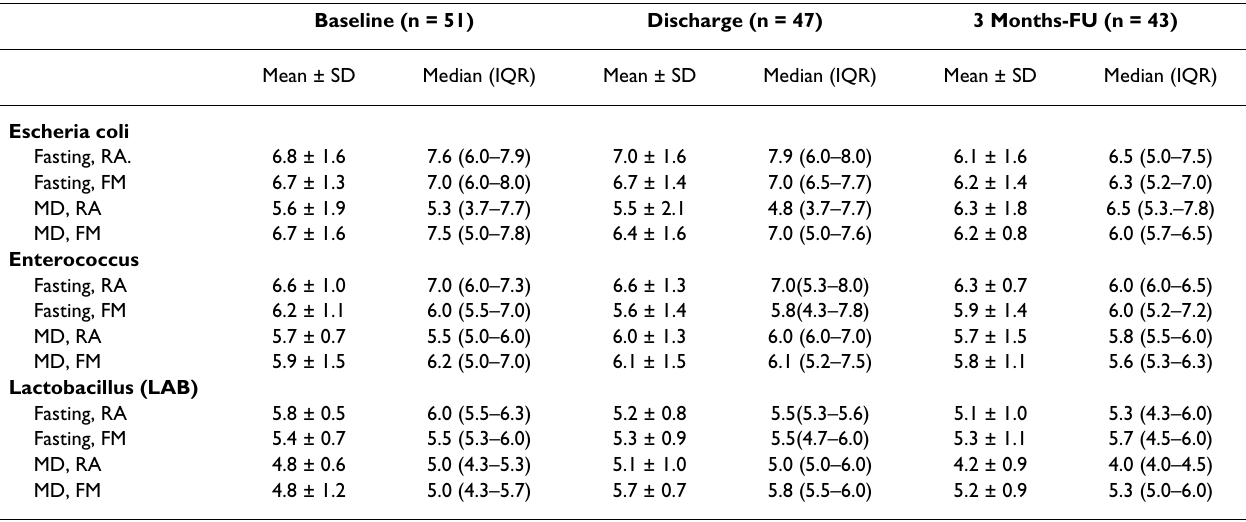
Table 2: Aerob and microaerophil (LAB) bacterial fecal flora: log. numbers of characteristic bacteria at the three timepoints in the different groups. No statistically significant change between time points within and between